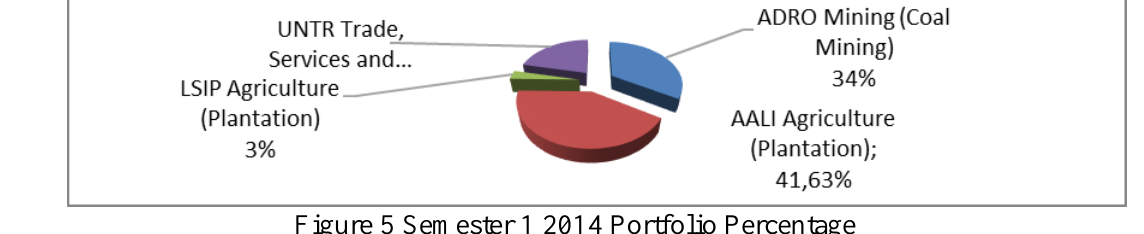
Figure 5 Semester 1 2014 Portfolio Percentage